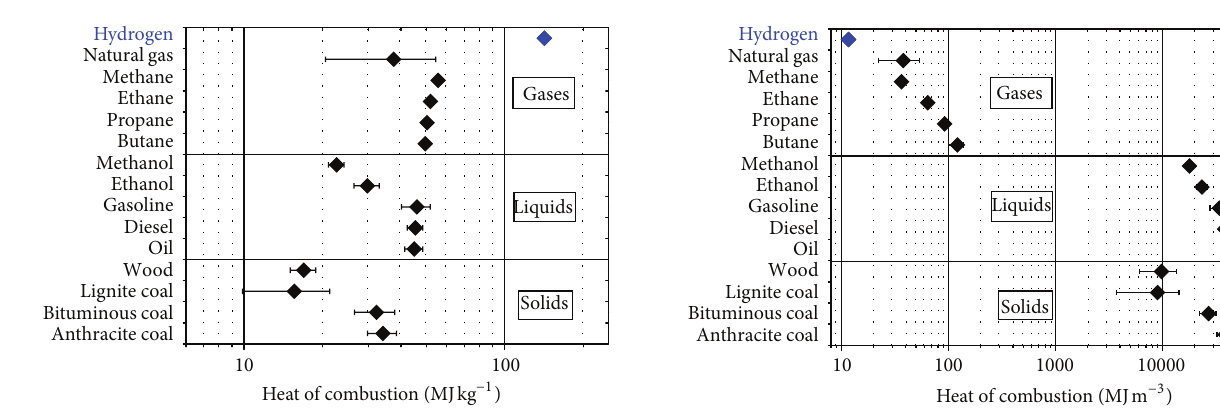
Figure 4: Heat of combustion on a volumetric basis, shown for various gaseous, liquid, and solid fuels under standard conditions. The ranges of values were obtained by utilizing a multitude of sources [18,